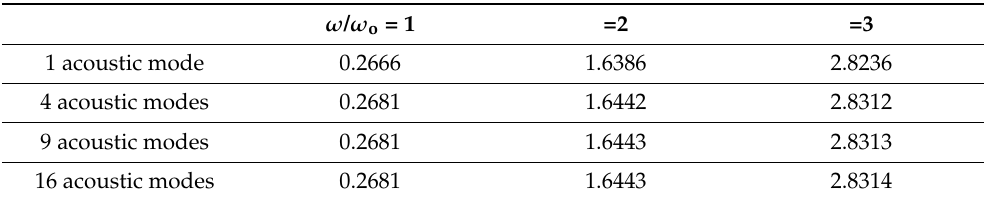
Table 2. Harmonic contributions of the elliptic cosine solution form for various driving frequencies ( c/a = 0.5, ξ =